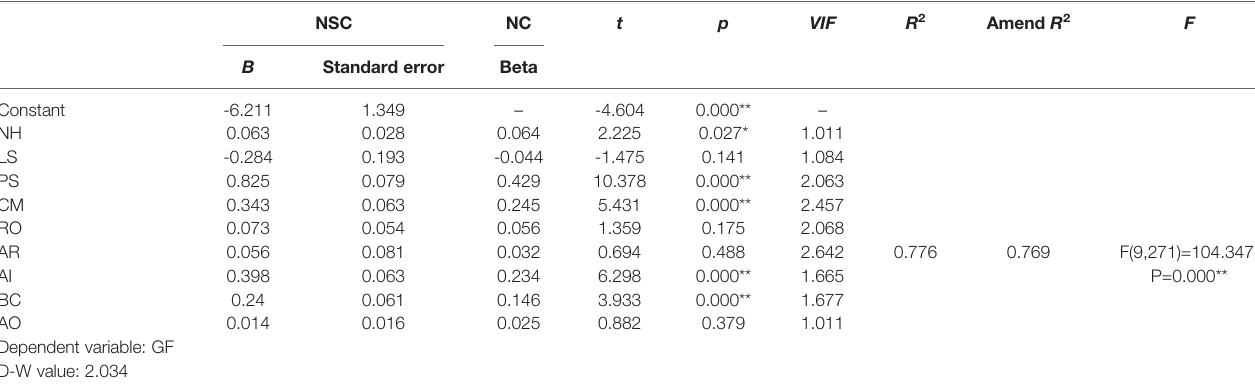
TABLE 2 | General functioning regression analysis results.